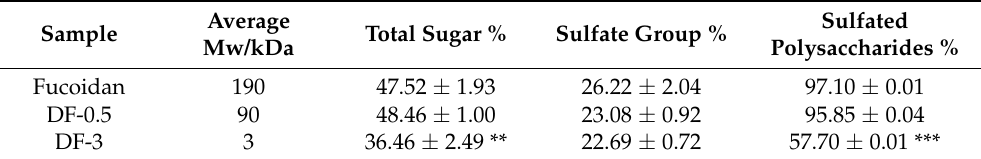
Table 1. Chemical compositions of fucoidan and its 2 degradation products (DF-0.5 and DF-3).